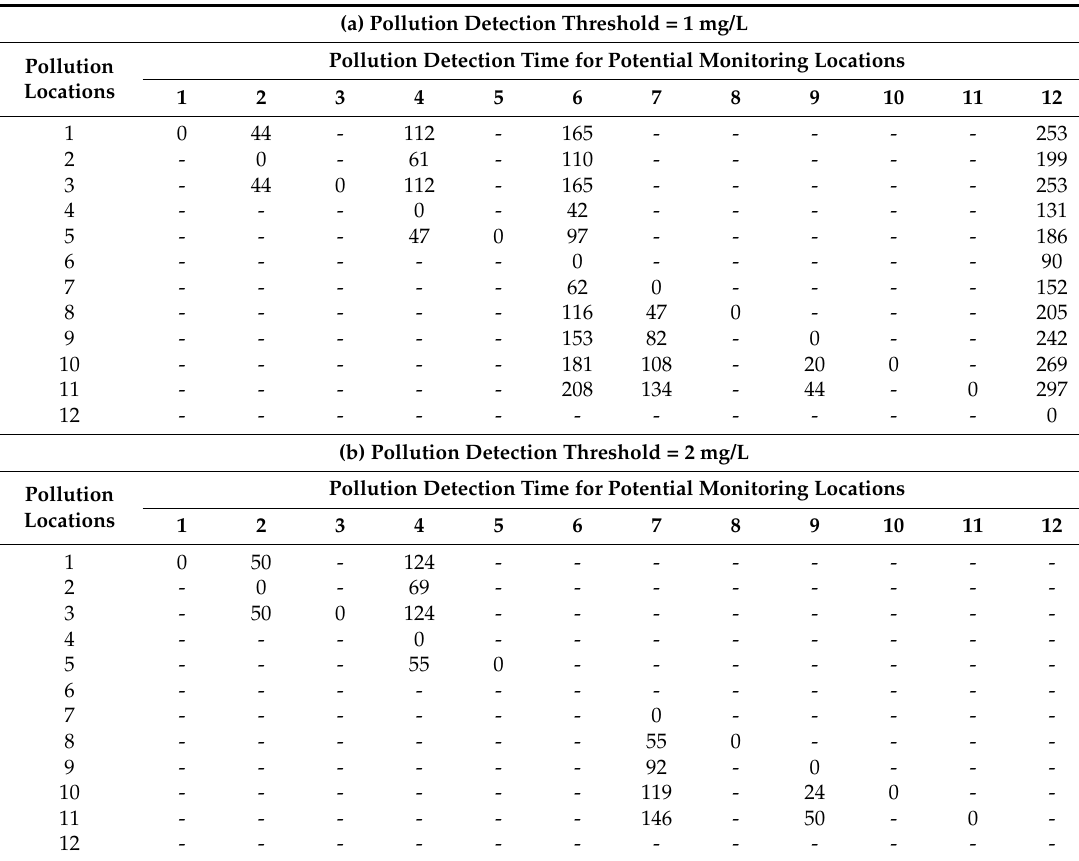
Table 8. Pollution detection time for river network A with higher pollution detection thresholds. (a) Pollution Detection Threshold = 1 mg/L